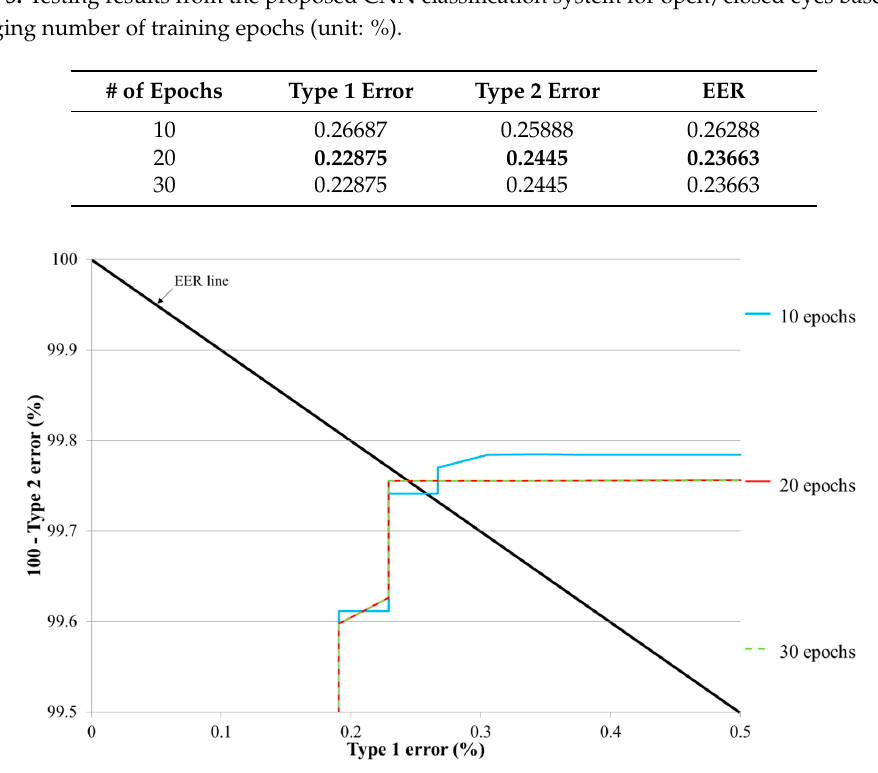
Table 4. Descriptions of training and testing databases in two-fold cross validation.